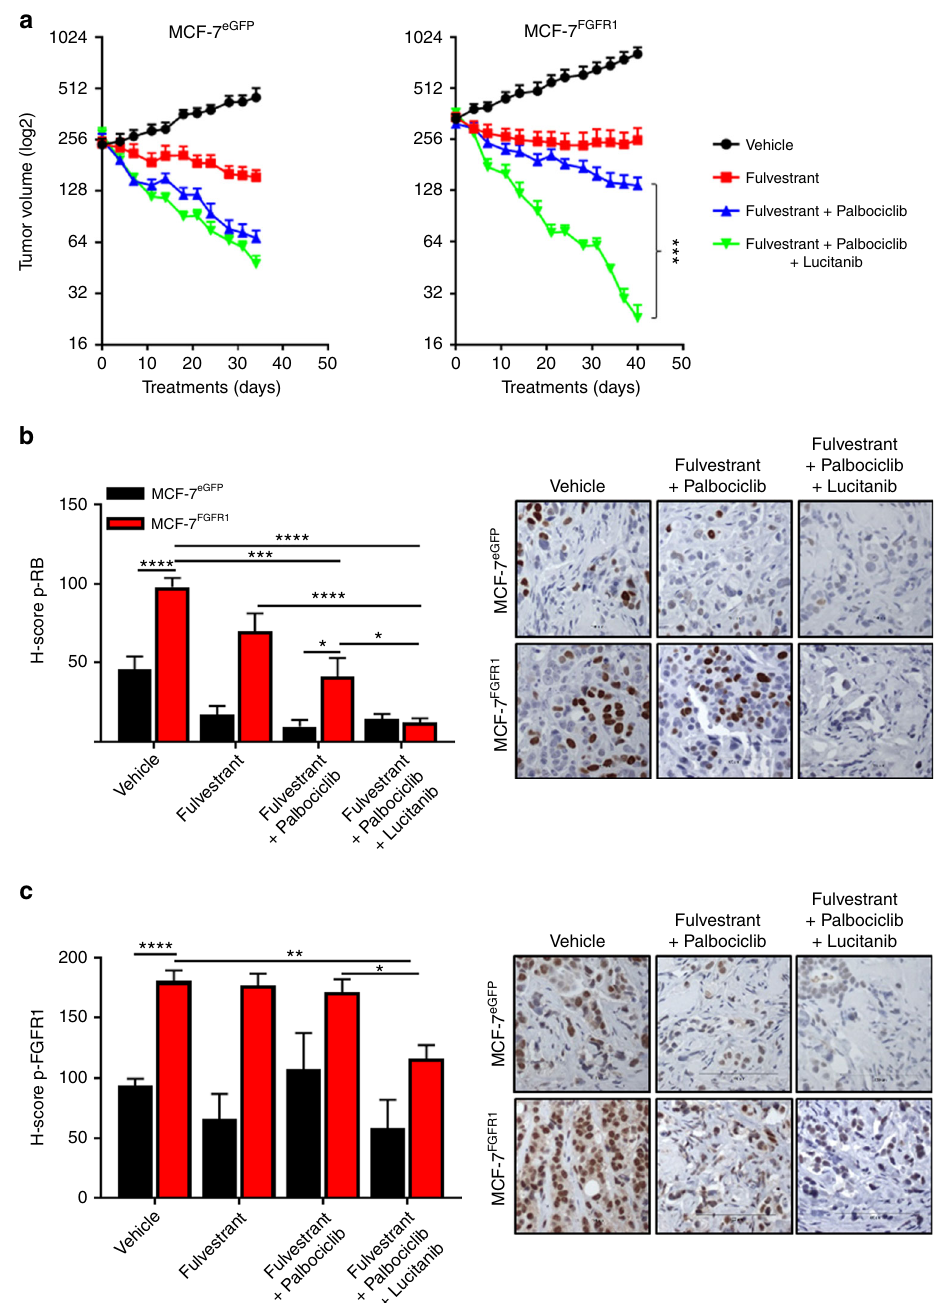
Fig. 3 FGFR inhibitor lucitanib enhances the action of fulvestrant plus palbociclib against MCF-7 FGFR1 xenografts. a MCF-7 eGFP (left) and MCF-7 FGFR1 (right) xenografts were established in ovariectomized athymic mice implanted with a s.c. 14-day release, 0.17-mg 17 β -estradiol pellet. Once tumors reached ≥ 200 mm 3 , mice were randomized to treatment with vehicle, fulvestrant (5 mg/week), fulvestrant plus palbociclib (30 mg/kg/day p.o.), or fulvestrant plus palbociclib plus lucitanib (10 mg/kg/day p.o.). Each data point represents the mean tumor volume in mm 3 ± SEM ( n = 8 per arm, **** p < 0.0001 vs. single drug arms; Student ’ s t -test). b , c MCF-7 eGFP and MCF-7 FGFR1 tumors were harvested at the end of the treatment. Formalin- fi xed, paraf fi n- embedded (FFPE) tumor sections were subjected to IHC with p-RB S807/811 ( b ) and p-FGFR1 Y653/4 ( c ) antibodies as described in Methods. The percent of p-RB + and p-FGFR1 + tumor cells and their staining intensity were assessed by an expert breast pathologist (P.G.E.) blinded to treatment to generate an H -score. Total p-RB and p-FGFR1 H -scores are shown (* p < 0.05, ** p < 0.01, *** p < 0.001, **** p < 0.0001; Student ’ s t